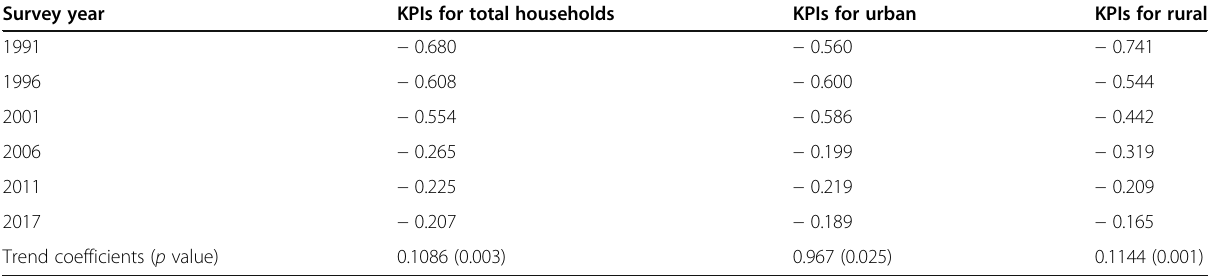
Table 2 KPIs for total, urban, and rural households over 6 years in Iran Survey year KPIs for total households KPIs for urban KPIs for rural